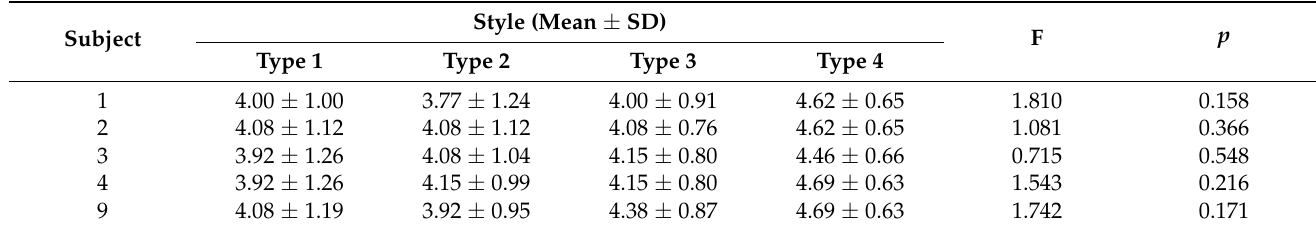
Table 18. Analysis of variance of user’s subjective preference data with different styles of keys.